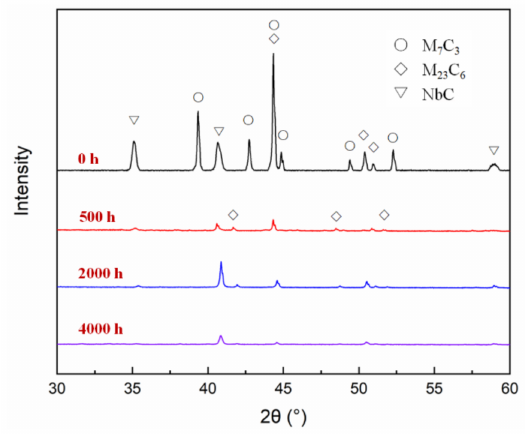
Figure 2. Representative XRD patterns of extracted residues in as-cast HP40Nb alloy and the specimens after aging at 990 ◦